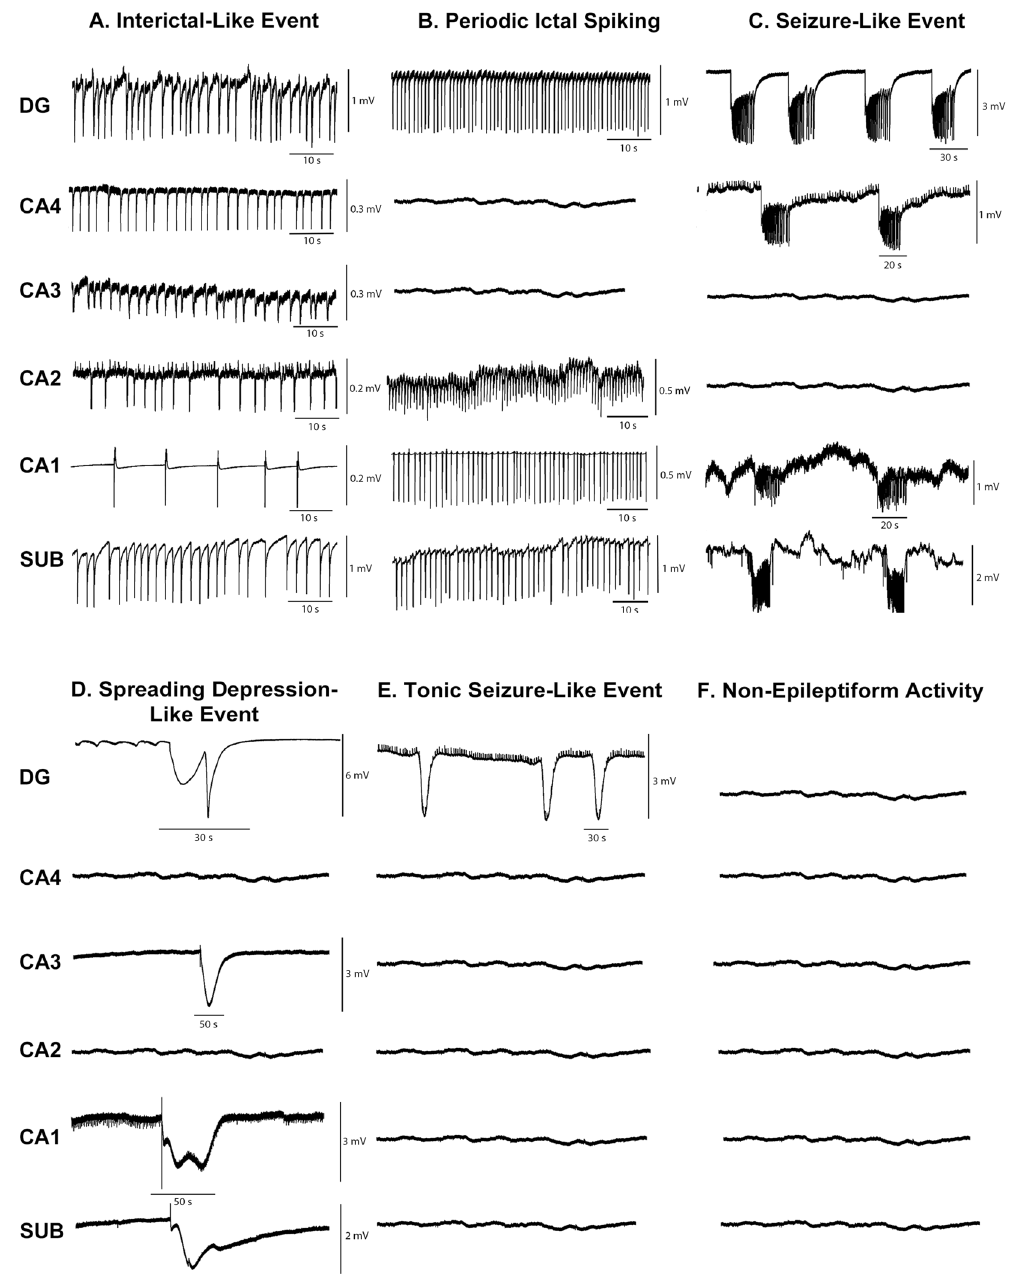
Figure 1. Epileptiform-like activity in hippocampal formation. Representative recordings of the different patterns of epileptiform-like activity in different regions of hippocampal formation. ( A ) Interictal-like events. ( B ) Periodic ictal spiking. ( C ) Seizure-like event. ( D ) Spreading depression-like events. ( E ) Tonic seizure- like events. ( F ) Non-epileptiform activity. Isoelectric recordings indicate that non-epileptiform activity was observed. Calibration bars for amplitude and time are given in each recording on the